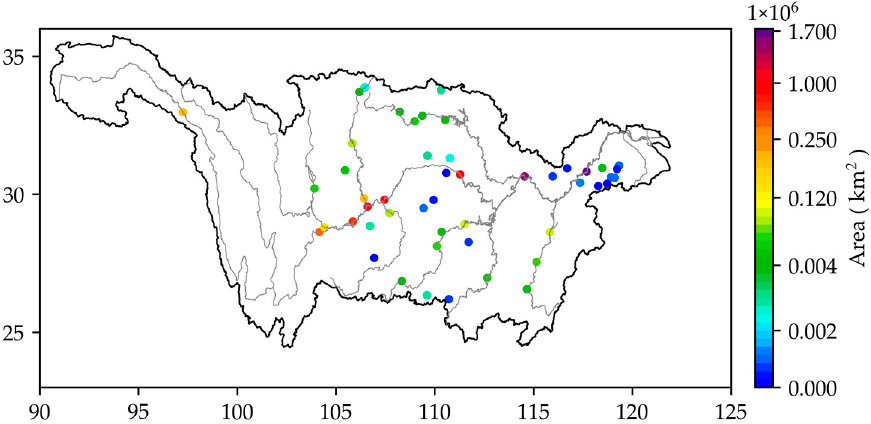
Figure 1. Locations and drainage areas (km 2 ) of 49 streamflow observational stations over the Yangtze River basin in southern China.